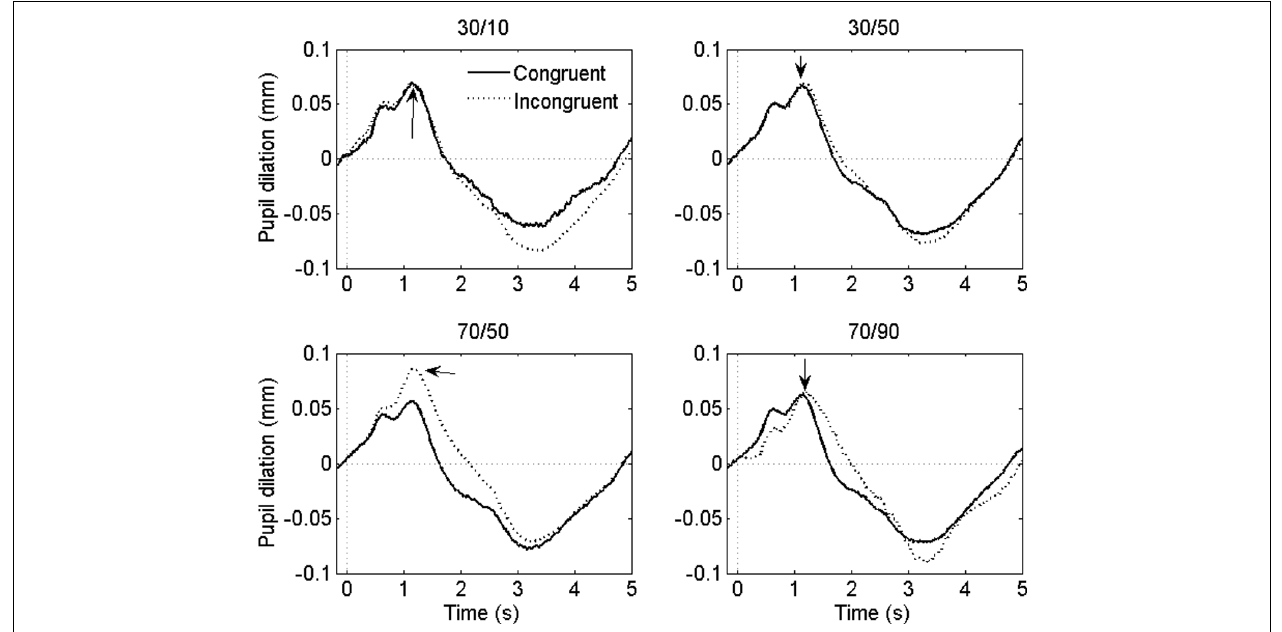
FIGURE 3 | Grand-average pupil waveforms in each task condition. Time = 0 ms indicates the onset of the stimulus.The arrows indicate the dilatory peaks the analysis was based